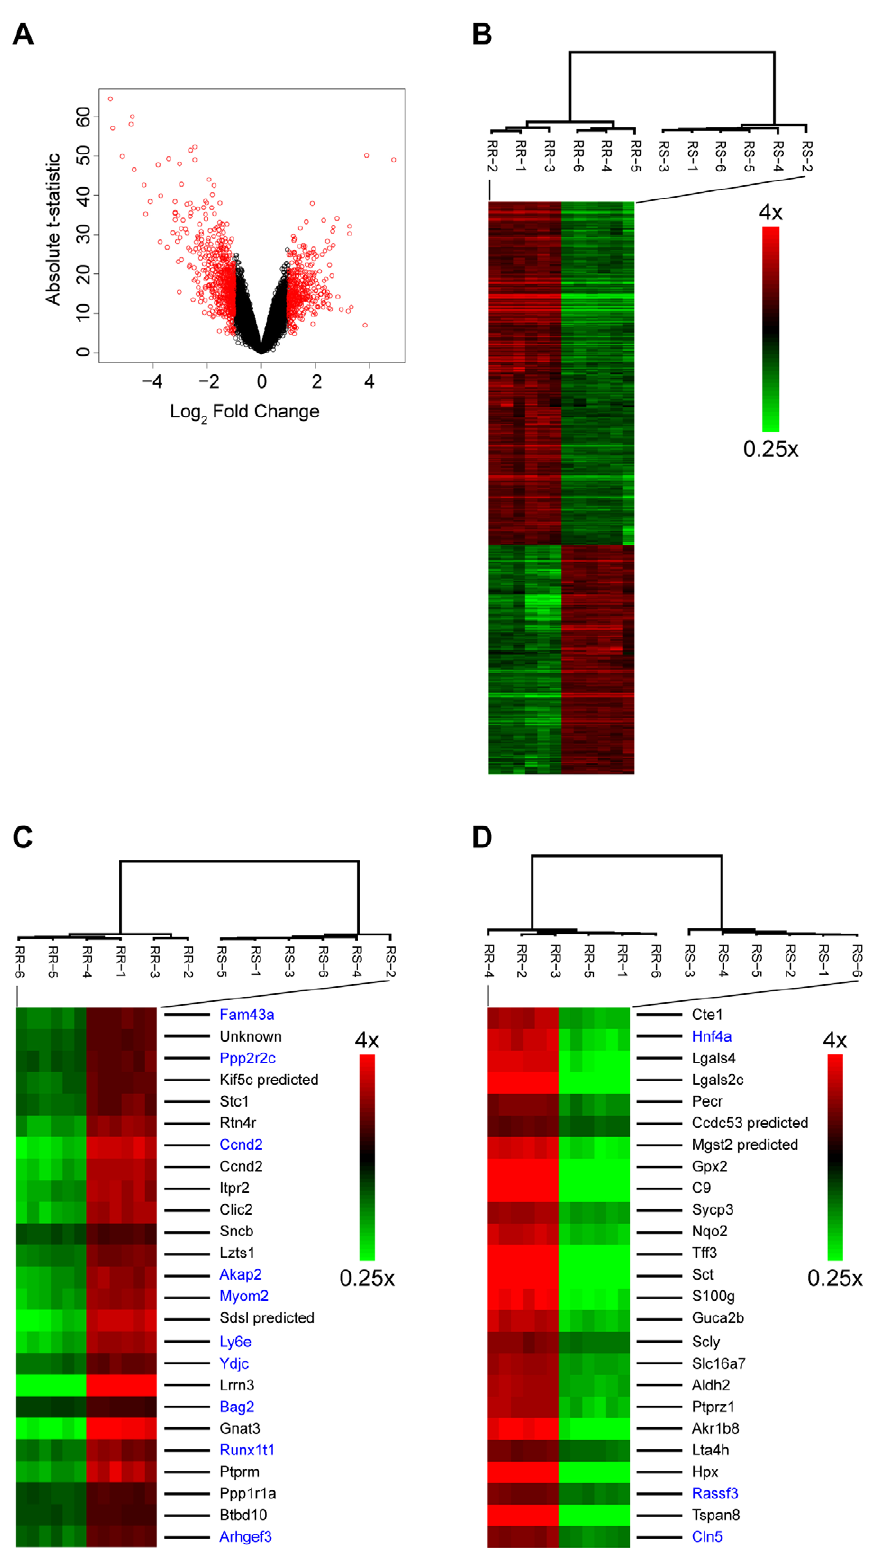
Figure 5. Analysis of gene expression data. A . The volcano plot shows that there are many significant genes with high fold change; significant genes (probes with FDR adjusted p-values , 0.05) with differential expression $ 2 fold are marked in red. B–D . Unsupervised hierarchical clustering shows that independent biological replicates of each cell type group together (high expressing genes, red; low expressing genes, green). The analyses were performed using 999 probesets with differential expression $ 2 fold (panel B), top 25 genes upregulated in RS cells (by p-value; panel C), and top 25 genes downregulated in RS cells (also by p-value; panel D). In panels C and D, black font is used for gene symbols identified by the